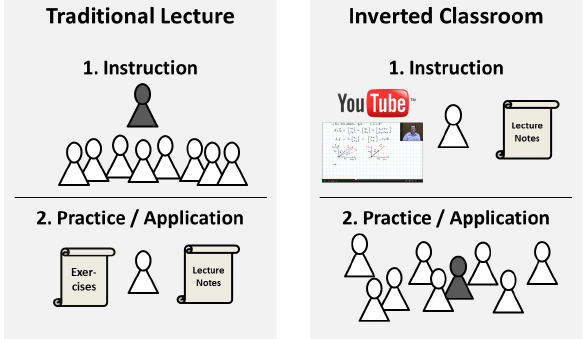
Figure 1. Inverted Classroom. The classroom time changes its role from instruction to practice and application. Individual study takes place before class using prerecorded lecture videos, possibly supplemented by reading materials [15]. T HE S TUDY S ETTING